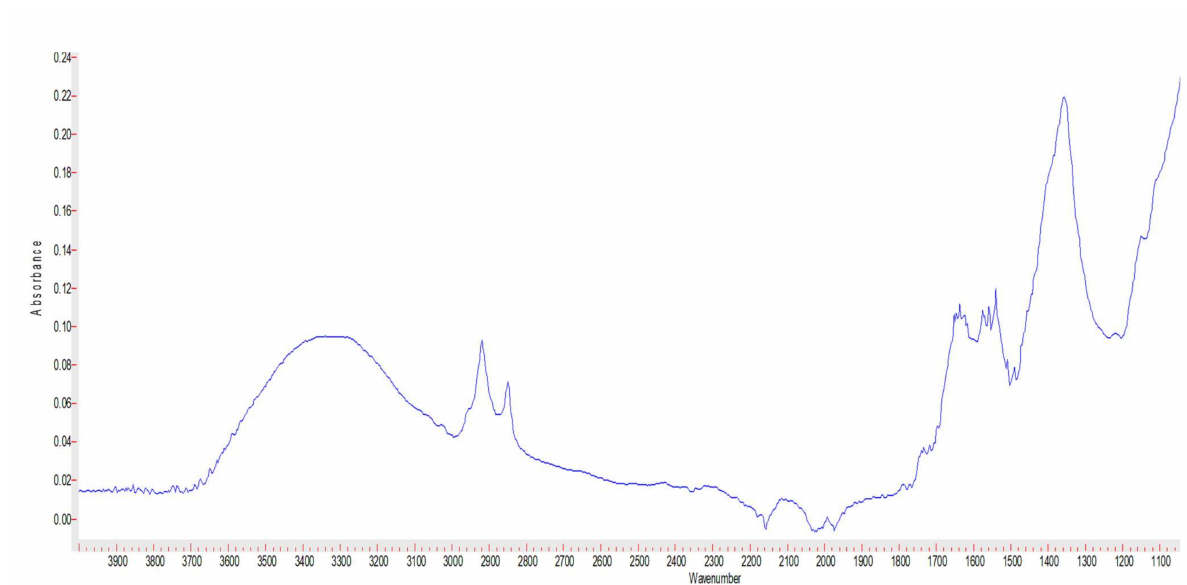
Figure 4. FTIR spectrum of nanosilver.